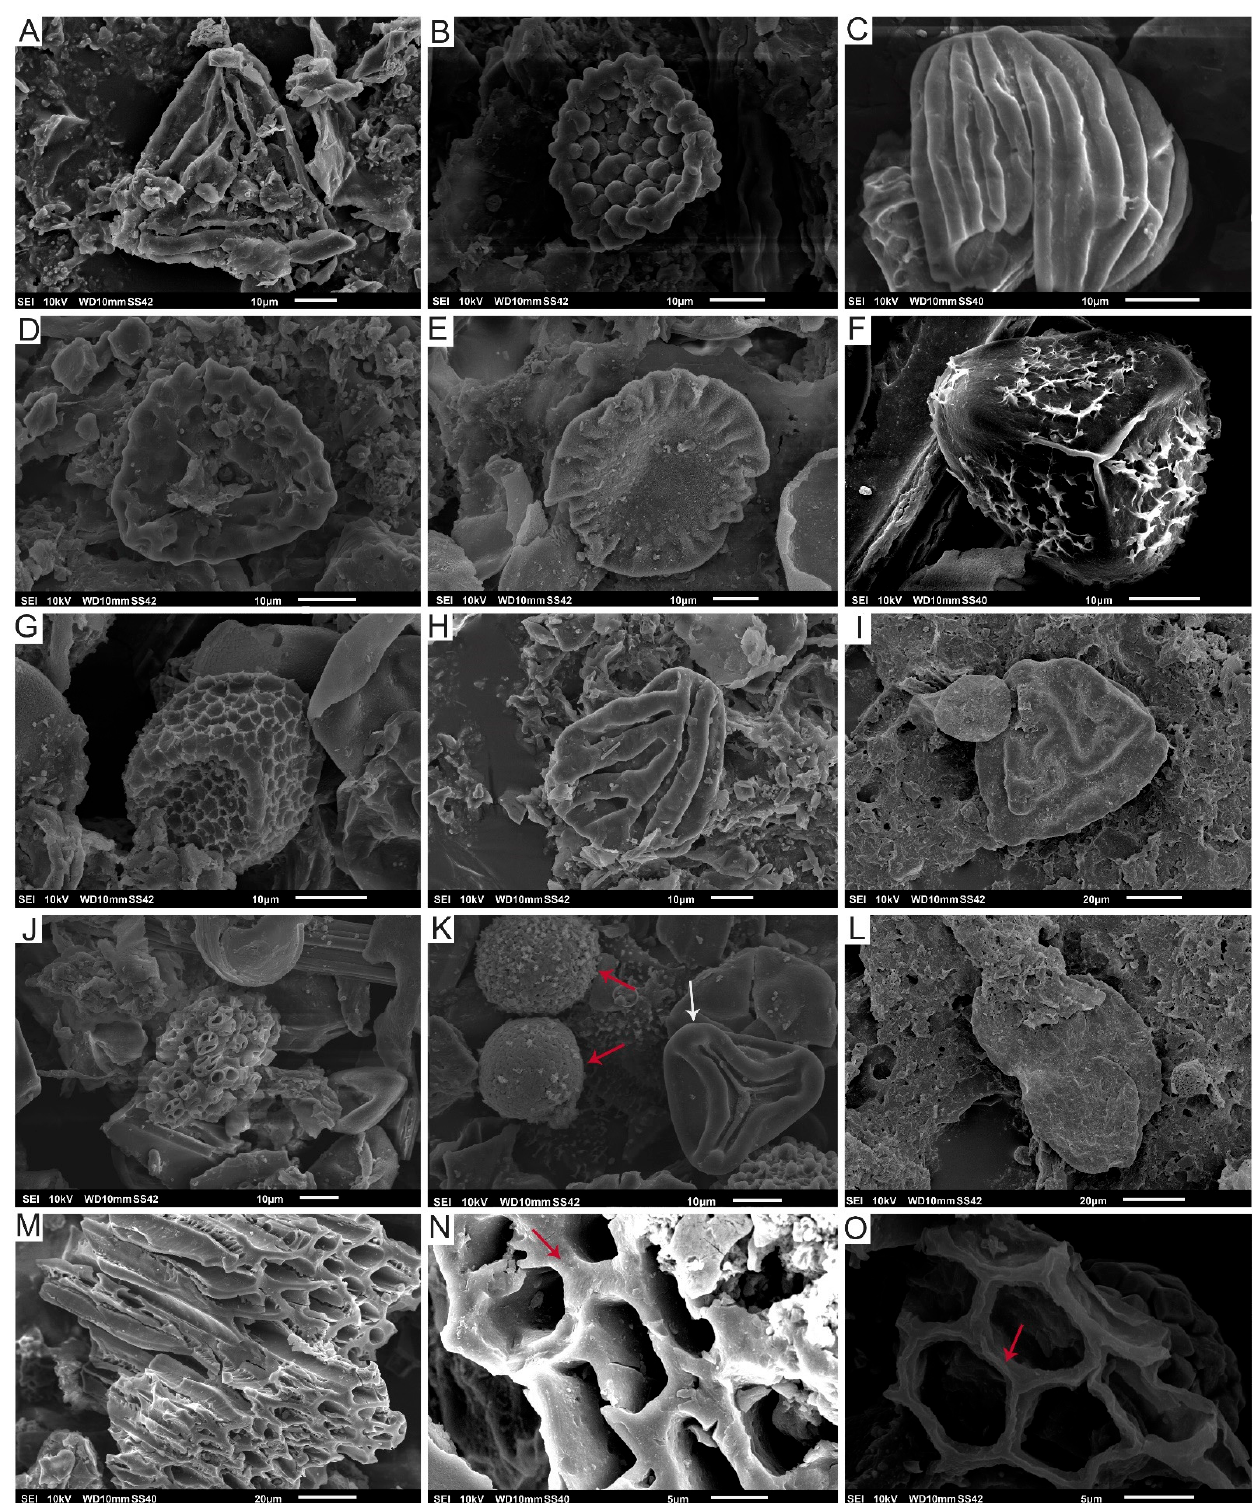
Figure 4. Palynomorphs from the Lastres Fm. under SEM: ( A ) Cicatricosisporites sp., SEM-V1b-Lastres; ( B ) Leptolepidites sp., SEM-VA-Lastres; ( C ) Contignisporites cooksonii , SEM-V1-Lastres; ( D ) Klukisporites sp., SEM-CA4-Lastres; ( E ) Callialasporites dampieri , SEM-V1-Lastres; ( F ) cf. Camarazono- sporites rudis , SEM-V1b-Lastres; ( G ) Retitriletes clavatoides , SEM-V1b-Lastres; ( H ) Striatella balmei , SEM-V3-Lastres; ( I ) Striatella scanica , SEM-CAb-Lastres; ( J ) Botryococcus sp., SEM-V1-Lastres; ( K )